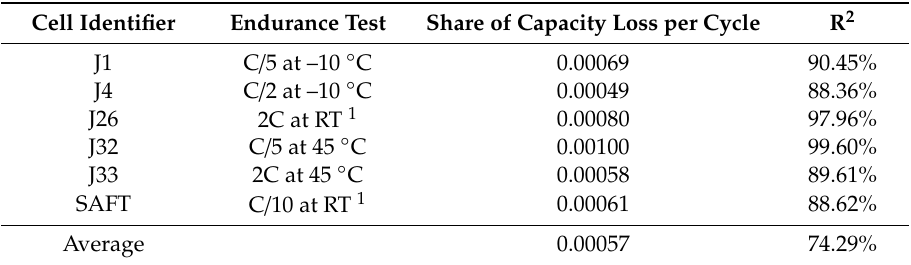
Table 5. Initial capacity of